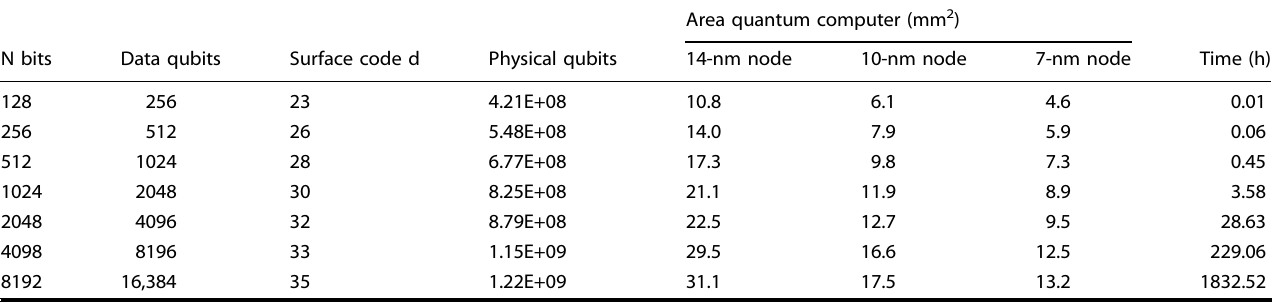
Area quantum computer (mm 2 )